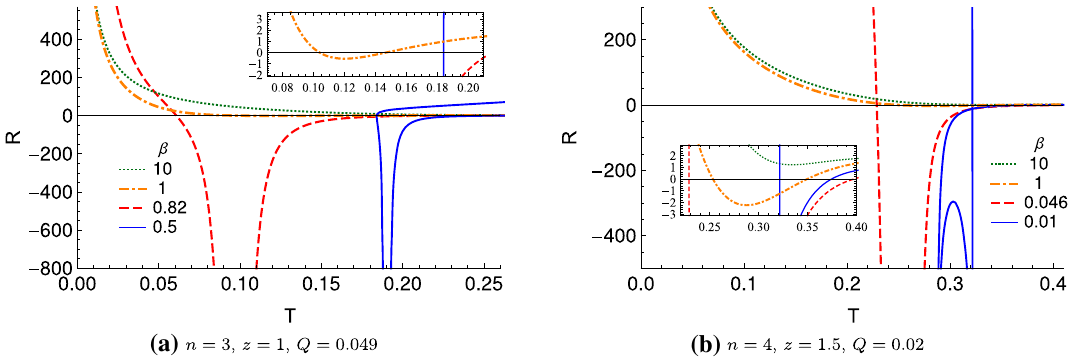
Fig. 8 The behavior of the Ruppeiner invariant R versus T for the Born–Infeld case with l = b = 1